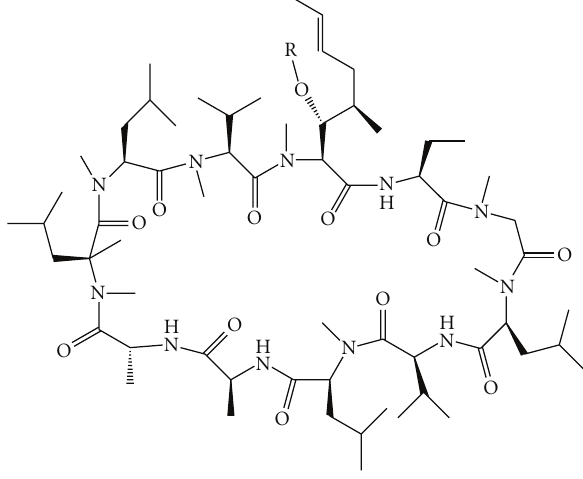
Figure 2: The structure of CsA